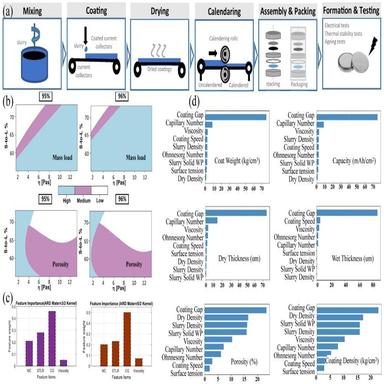
(a) Generalized electrode process chain. (b) SVM classification in terms of the mass load and porosity for the dried electrodes for different MC amounts. Reproduced with permission from Ref. . Copyright 2020, Wiley. (c) Obtained feature weights through using various automatic relevance determination kernels. Reproduced with permission from Ref. . Copyright 2021, Elsevier. (d) Obtained feature weights through using XML. (a and d) were reproduced with permission from Ref.